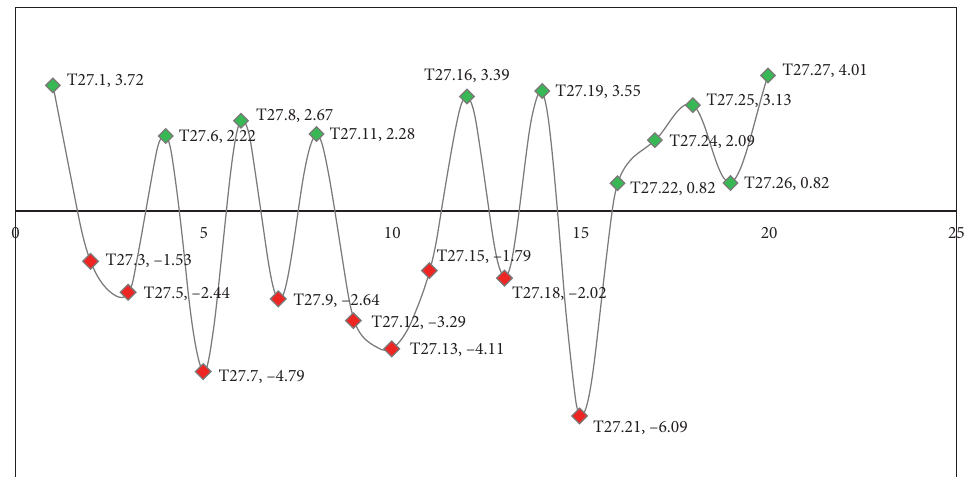
Figure 16: Impact of research trends during time frame 2015–2019.